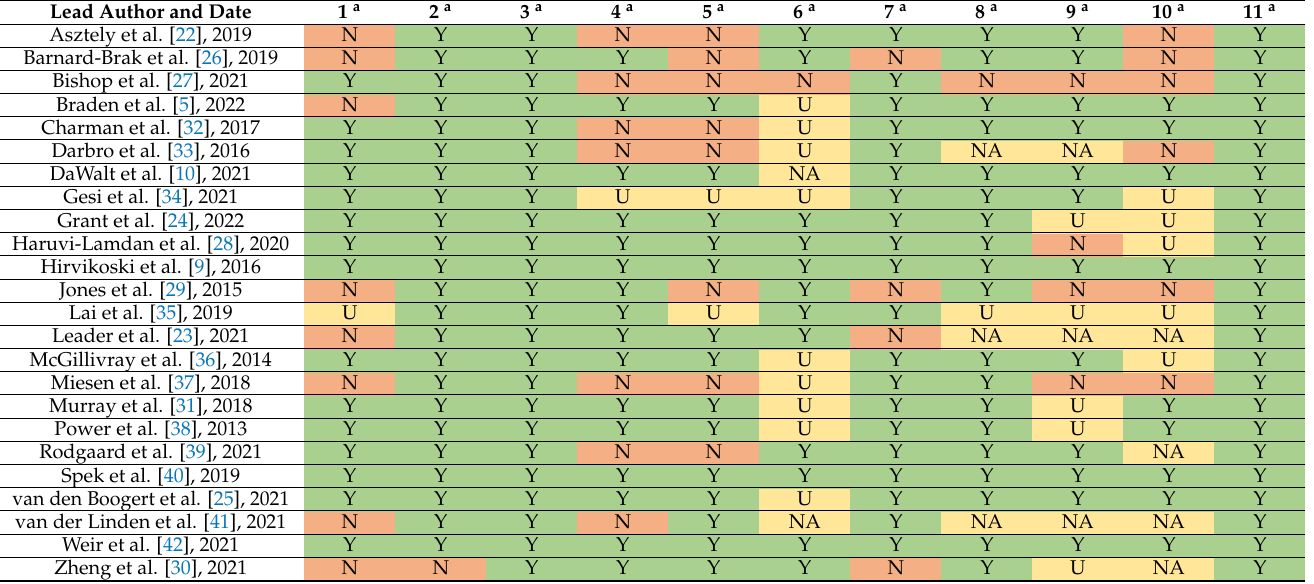
a : The numbers correspond to the quality assessment criteria as described in the table below: 1. Were the two groups similar and recruited from the same population? 2. Were the exposures measured similarly to assign people to both exposed and unexposed groups? 3. Was the exposure measured in a valid and reliable way?